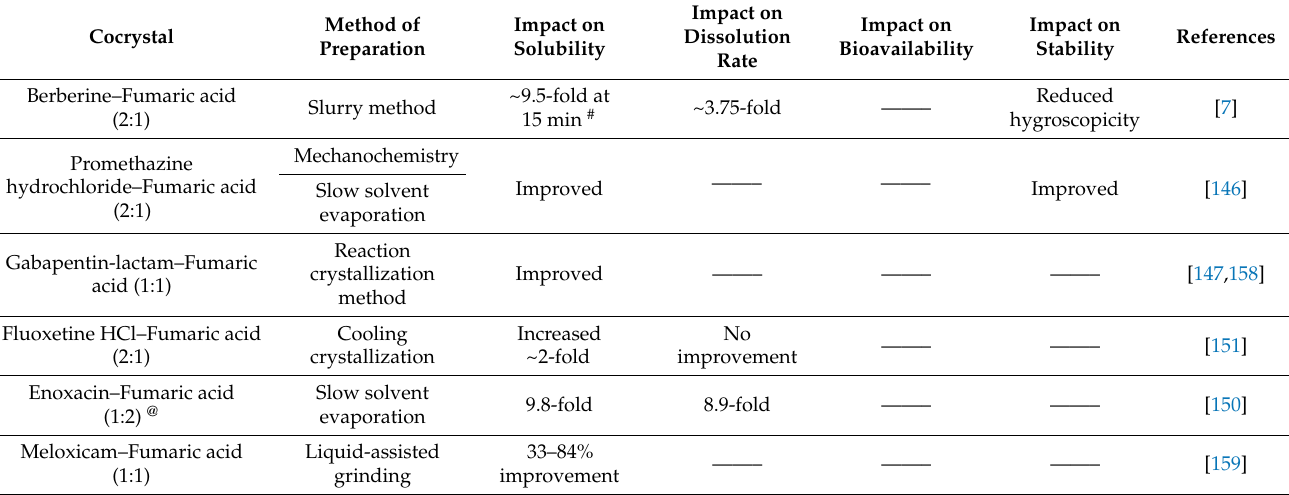
Table 8. Impact of fumaric acid as coformer on drugs.